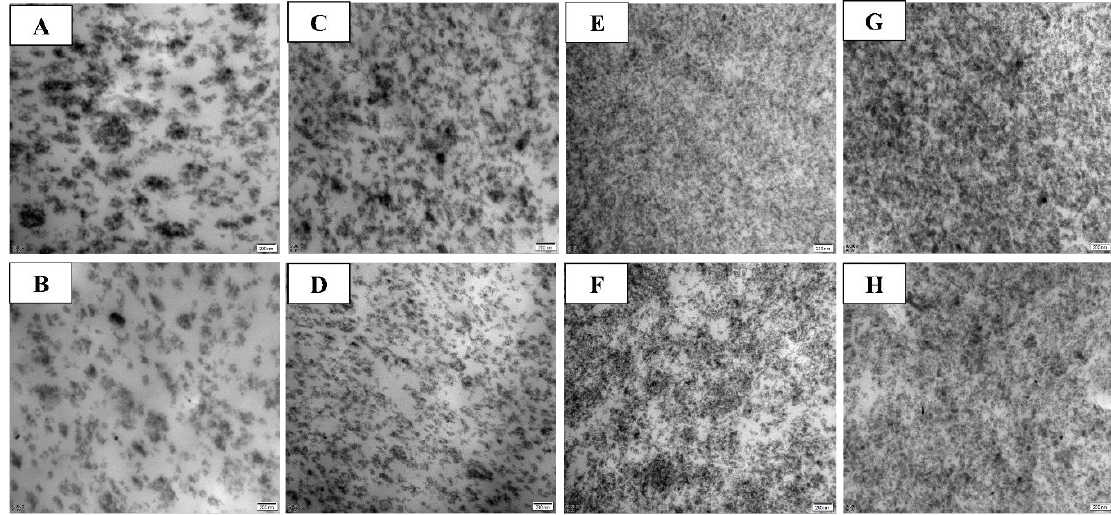
Figure 6. Transmission electron microscopy (TEM) images of the Si69- ( A , C , E and G ) or Si69/[EMIM]OAc-containing vulcanizates ( B , D , F and H ) at φ = 0.041 ( A and B ), 0.079 ( C and D ), 0.147 ( E and F ), and 0.177 ( G and H ).